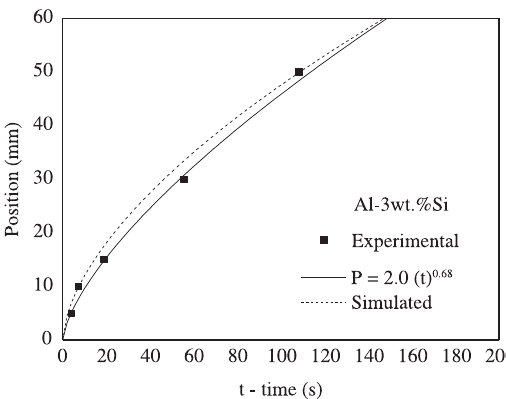
Figure 6. Experimental position of liquidus isotherm from the metal-mold interface as function of time.